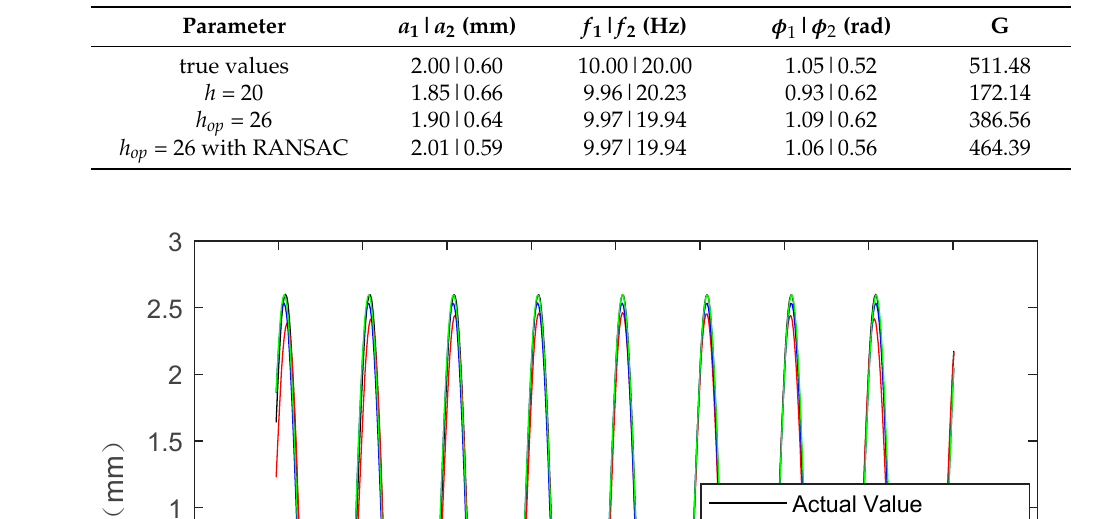
Table 4. Estimated parameter values.